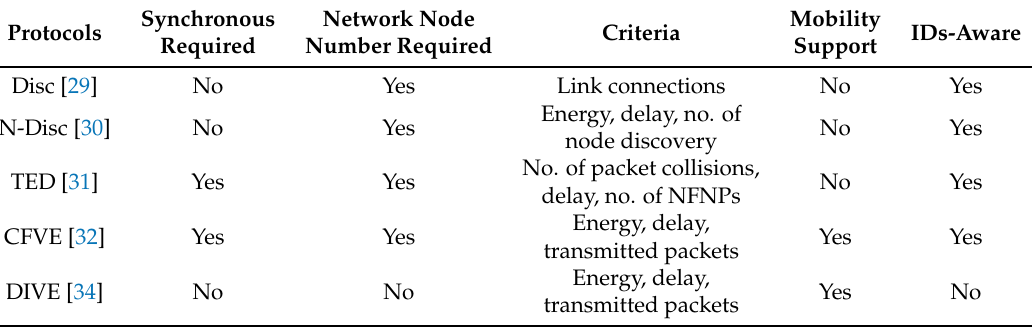
Table 1. Comparison of the Existing Topology Discovery Protocols for